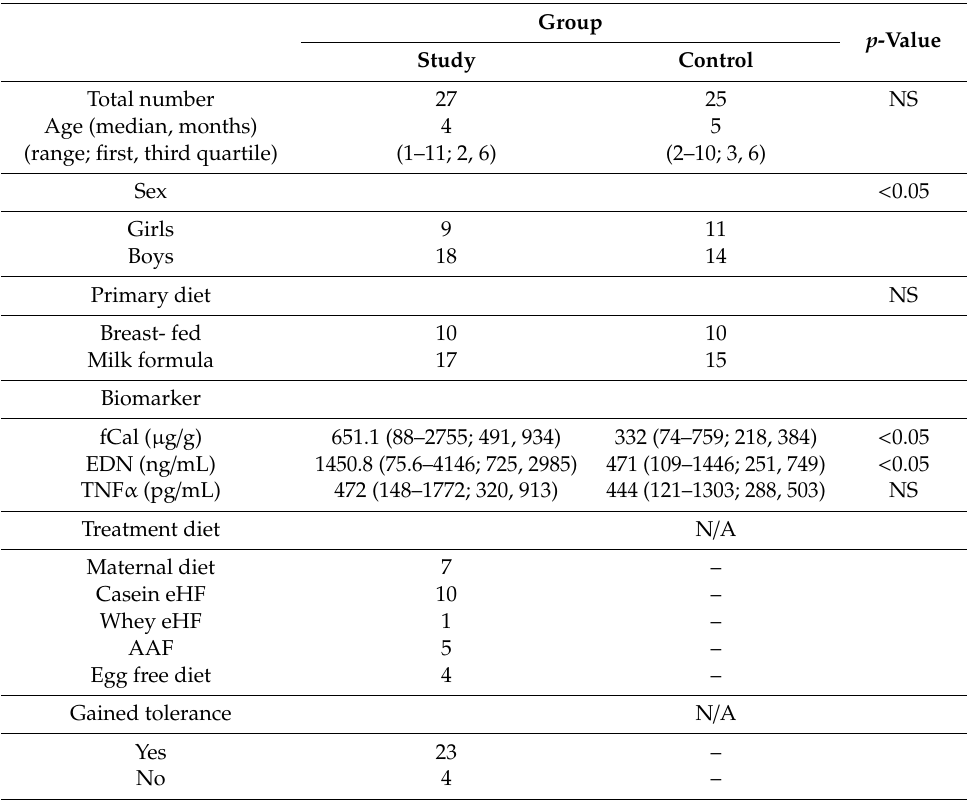
Table 1. Background data, median (min-max; first, third quartile) values of fecal biomarkers among study and control groups. Significance is accepted at p < 0.05.